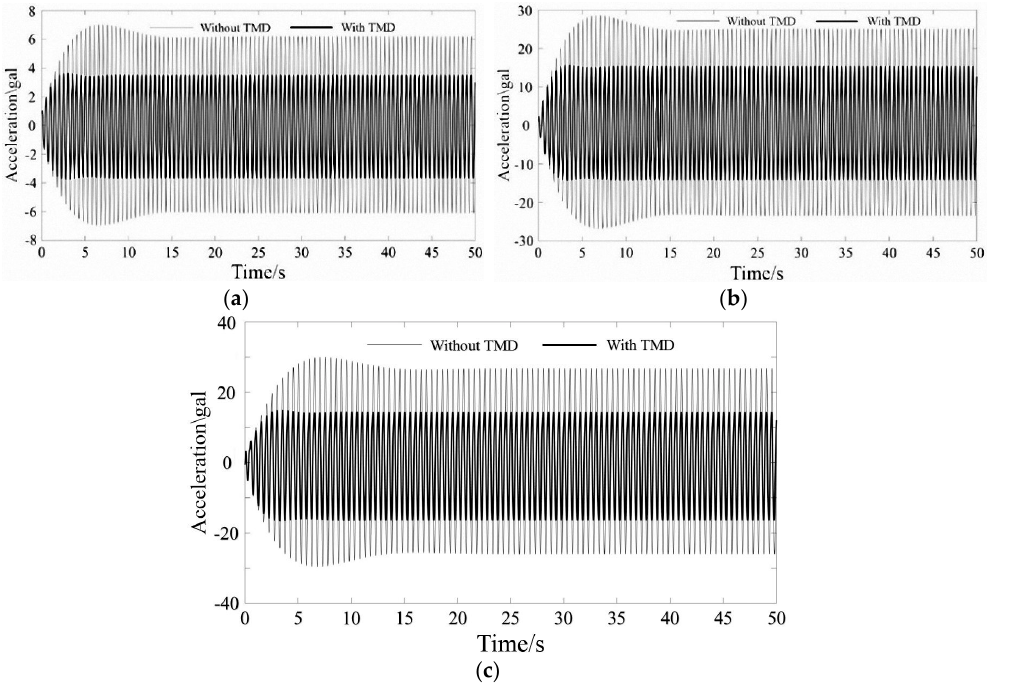
Figure 6. The comparisons of structural responses under 2.00 Hz human-induced excitations. ( a ) Under 2.00 Hz walking excitation; ( b ) Under 2.00 Hz running excitation; ( c ) Under 2.00 Hz jumping excitation.